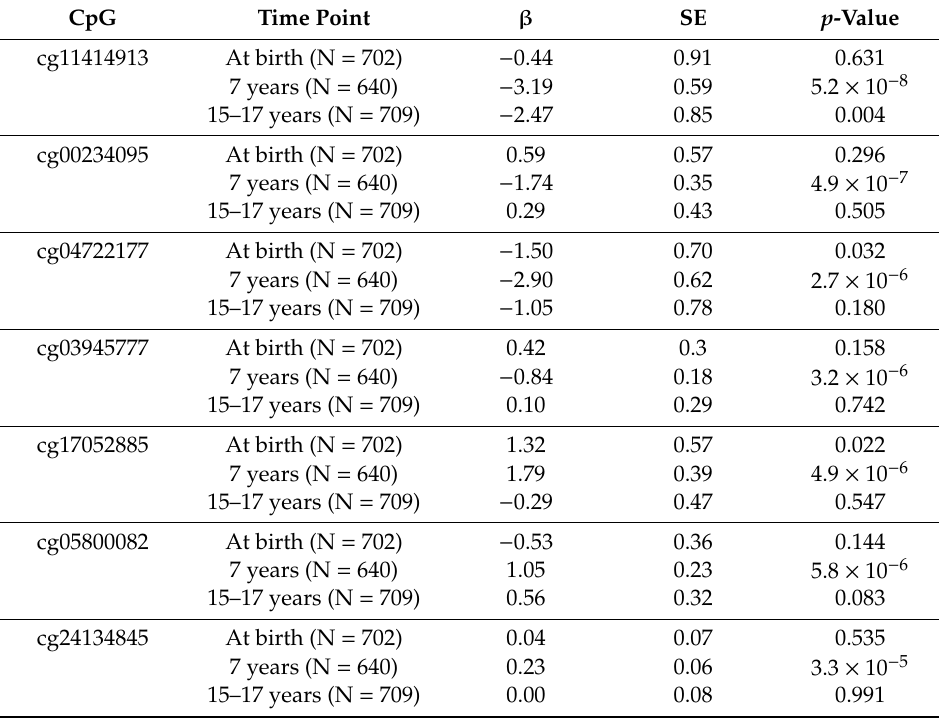
Table 3. Average percent point di ff erences ( β ) in DNA methylation at di ff erent ages according to